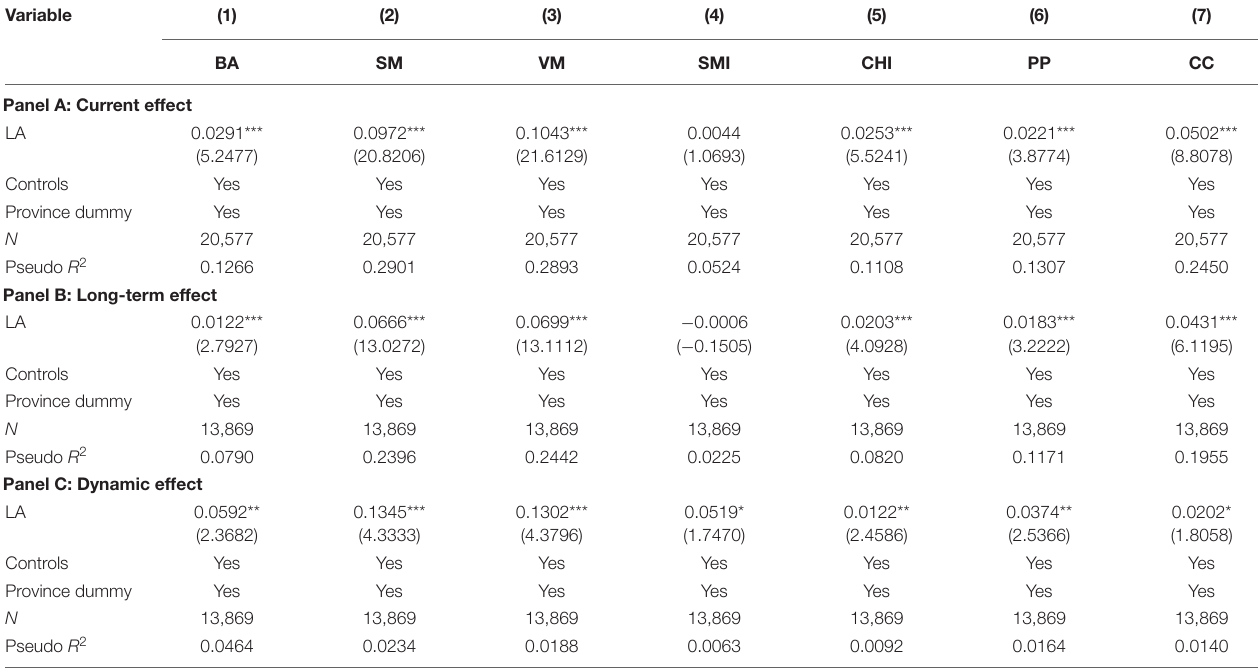
TABLE 6 | The impact of limited attention on financial